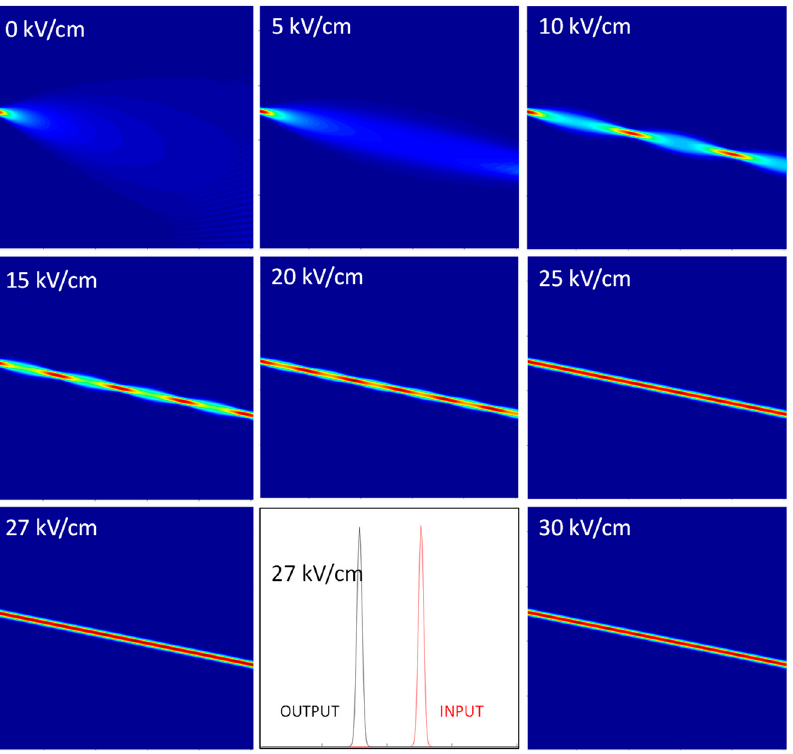
Figure 1. Self-focusing, self-confinement and solitonic regimes as function of the static applied bias. Without bias, beam diffraction occurs. At 5 kV/cm, self-focusing is present. Between 10 and 20 kV/cm, the beam is self-confined, with a very strong pulsing. Above this bias, pulsing is reduced and the beam gets a homogeneous shape. The pure soliton regime is reached at 27 kV/cm for which the input and output beam profiles coincide. Above this formation threshold, the beam maintains a solitonic profile.